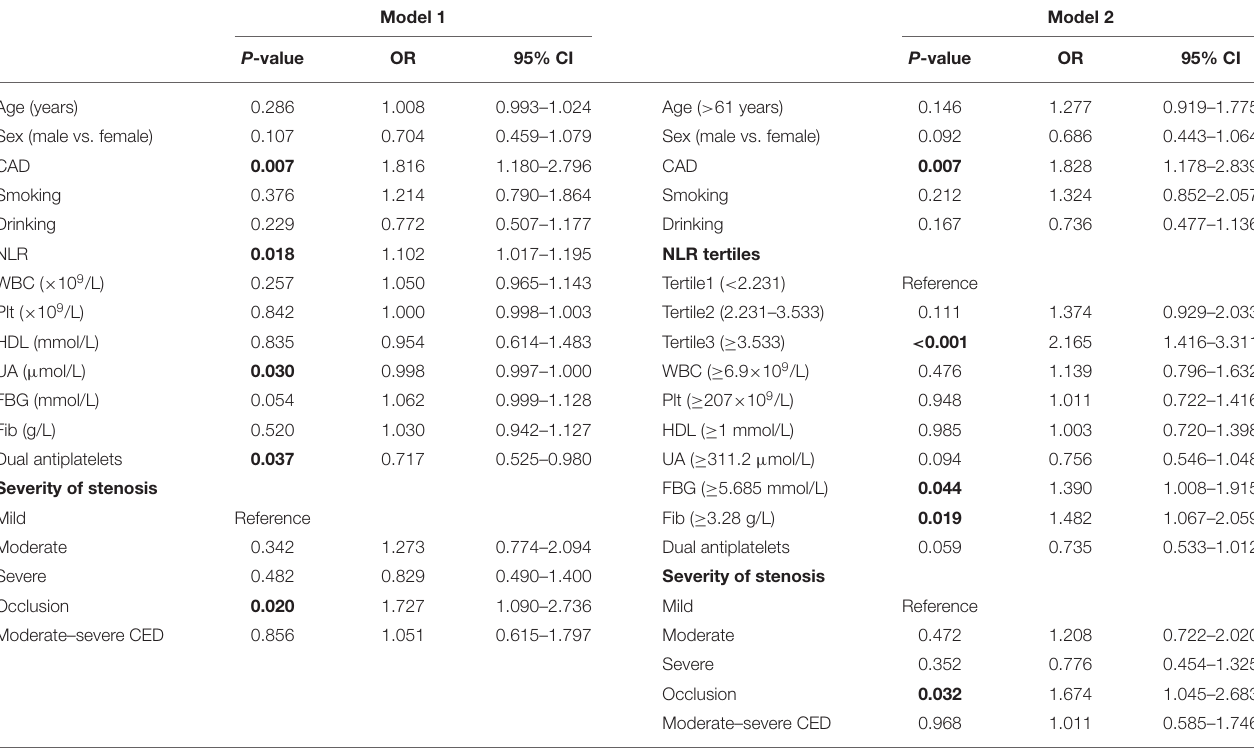
TABLE 4 | Multivariate logistic regression analysis of the relationship between NLR and the short-term prognosis of sICAS.